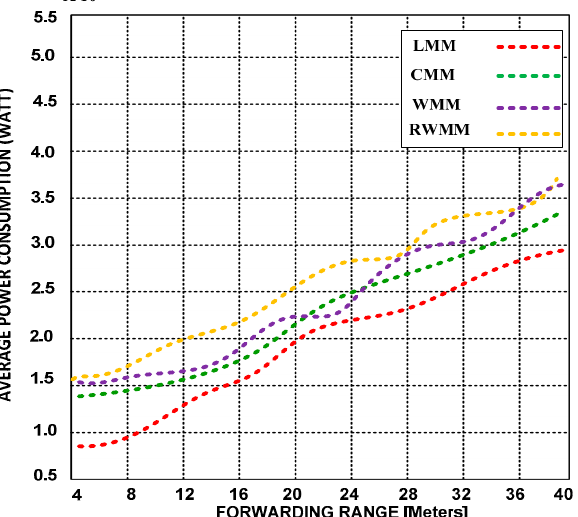
Figure 7. Power consumption versus forwarding range at 50 m event range and 50% mobility rates.